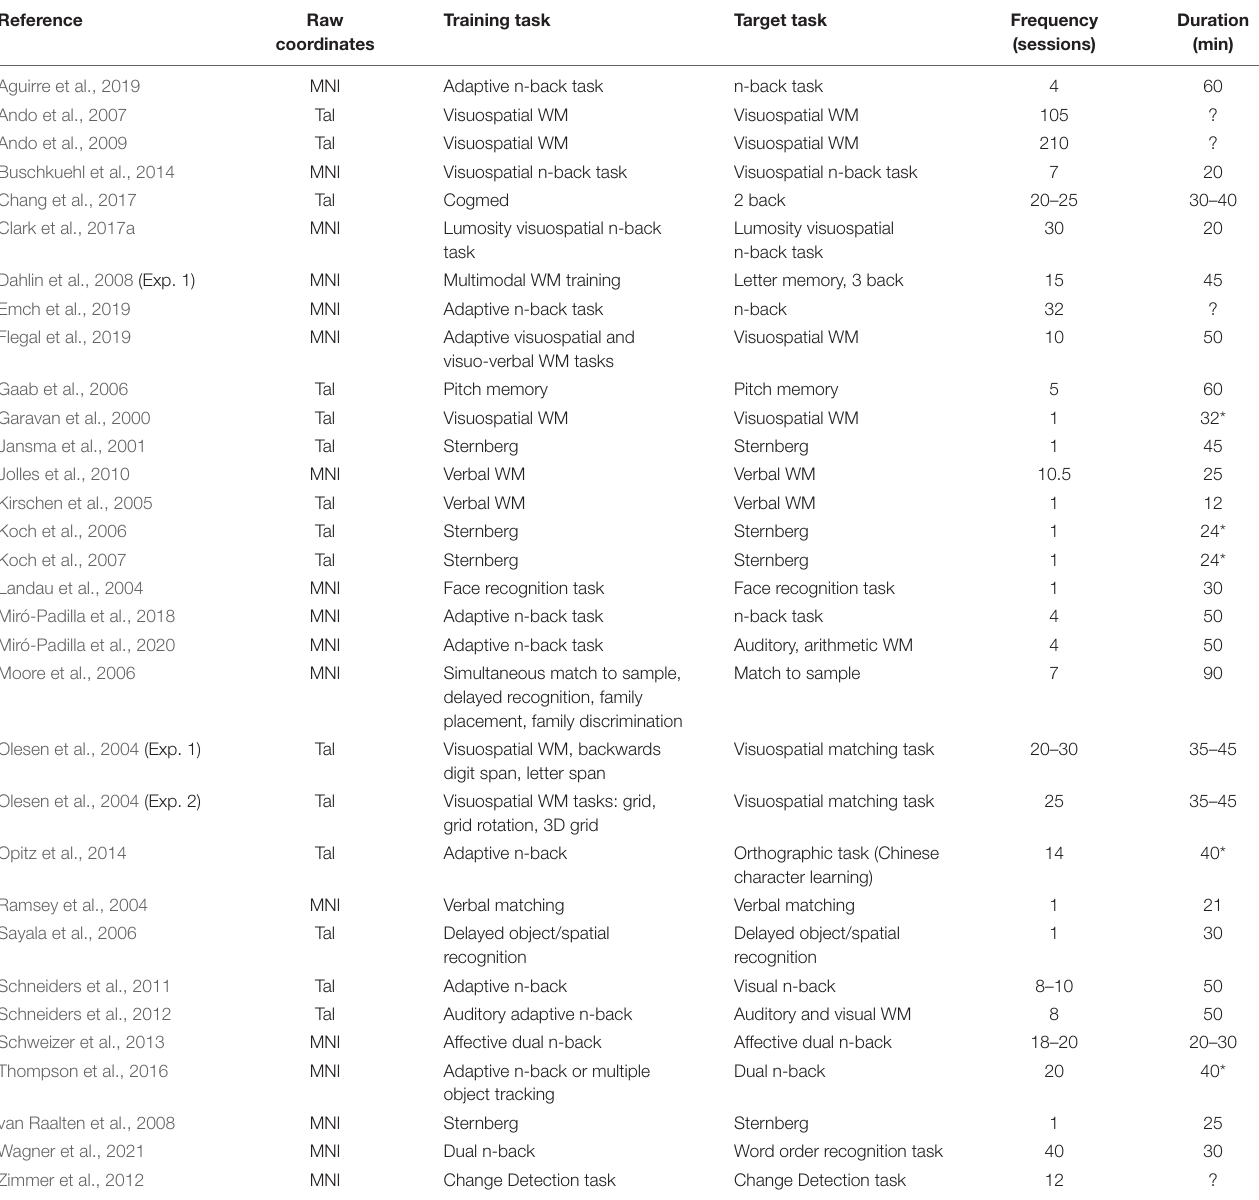
TABLE 1 | List of 32 studies included in the